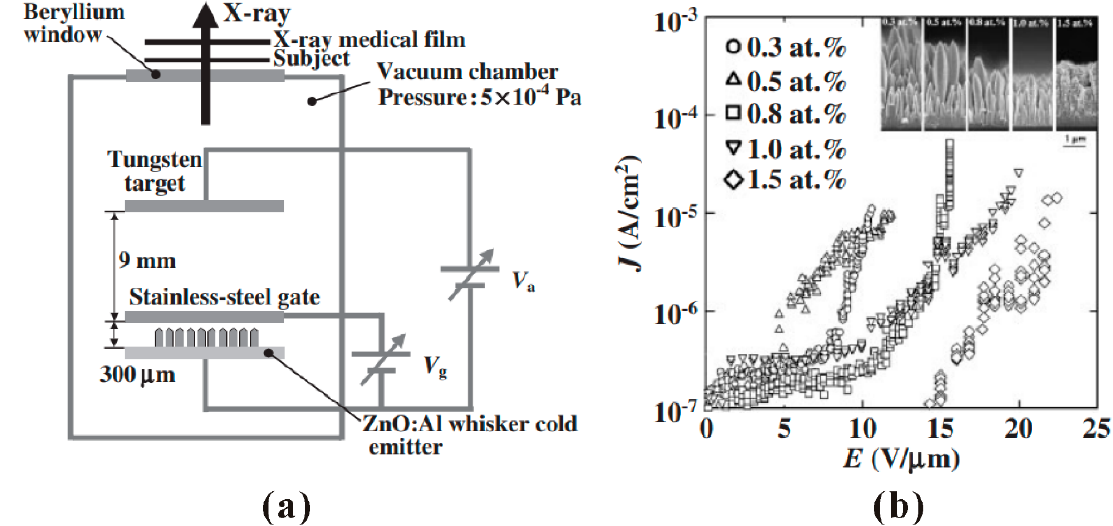
Figure 2. Demonstration of a X-ray source based on chemical vapor deposition (CVD)-synthesized ZnO:Al whiskers. ( a ) Schematic diagram of the discrete device structure. ( b ) Field emission properties of ZnO:Al whiskers with different Al concentration. The inset shows the morphology of the whiskers. Reproduced from [22], with the permission of the Japan Society of Applied Physics, 2008.